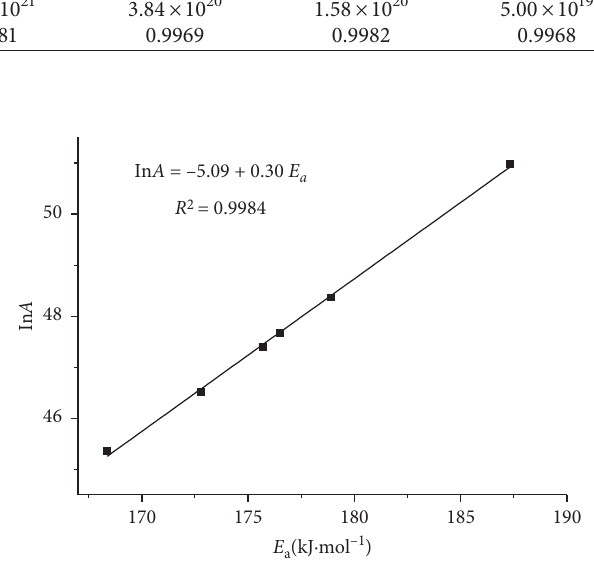
Figure 6: ln A vs E a with different values of Φ